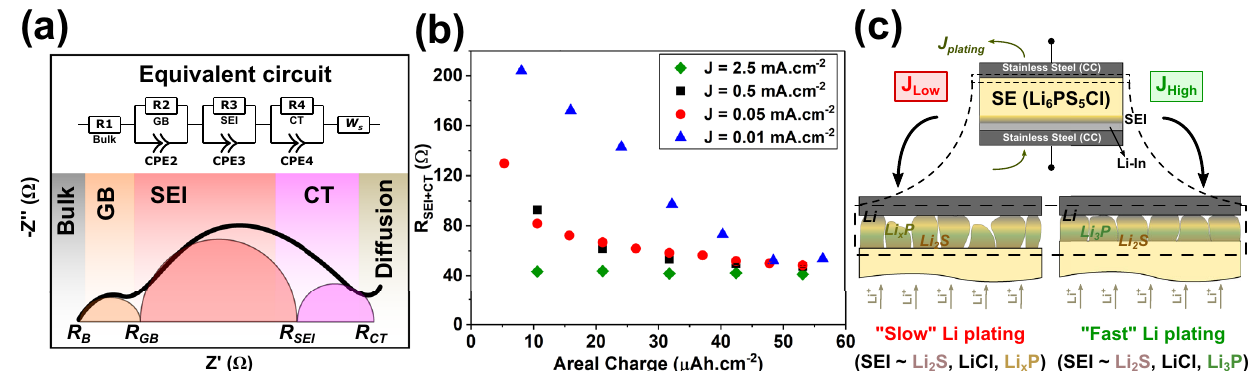
Fig. 4 | Interpretation of EIS spectra. a Equivalent circuit used for fi tting the EIS dataalongwithaschematicdescribingtheimpedancecontributionsfromthebulk ( R B ), grain boundaries ( R GB ), SEI ( R SEI ) and charge transfer ( R CT ) processes 40,41 . b Variationininterfacialresistance, R int ( R SEI + R CT ),from fi ttedEISdataasafunction of the amount of charge passed during Li plating at current densities, J 2.5 =2.5